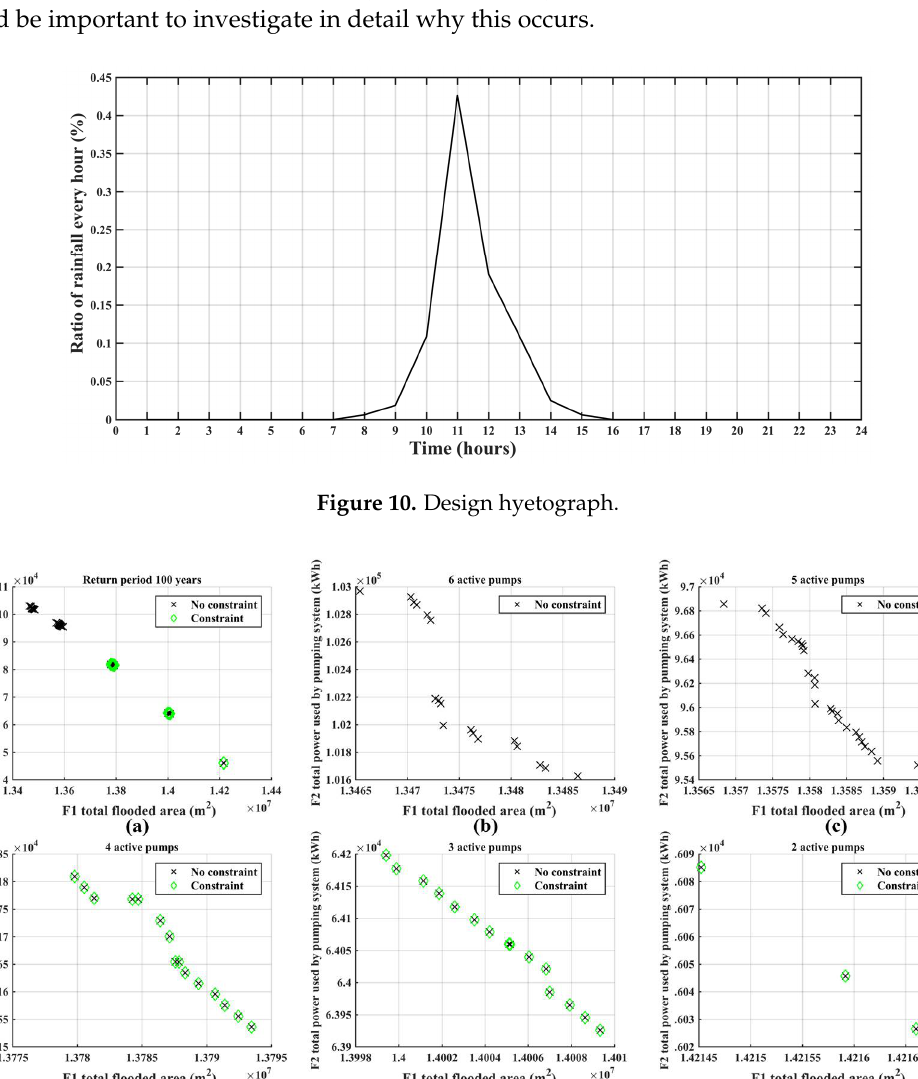
Figure 11. Pareto sets for daily rainfall amount with return period of 100 years. ( a ) Pareto set with all the pumping configurations. ( b ) Optimal Pareto set with a maximum of six pumps simultaneously working; and with ( c ) maximum of five pumps; ( d ) maximum of four pumps; ( e ) maximum of three pumps; ( f ) maximum of two pumps.